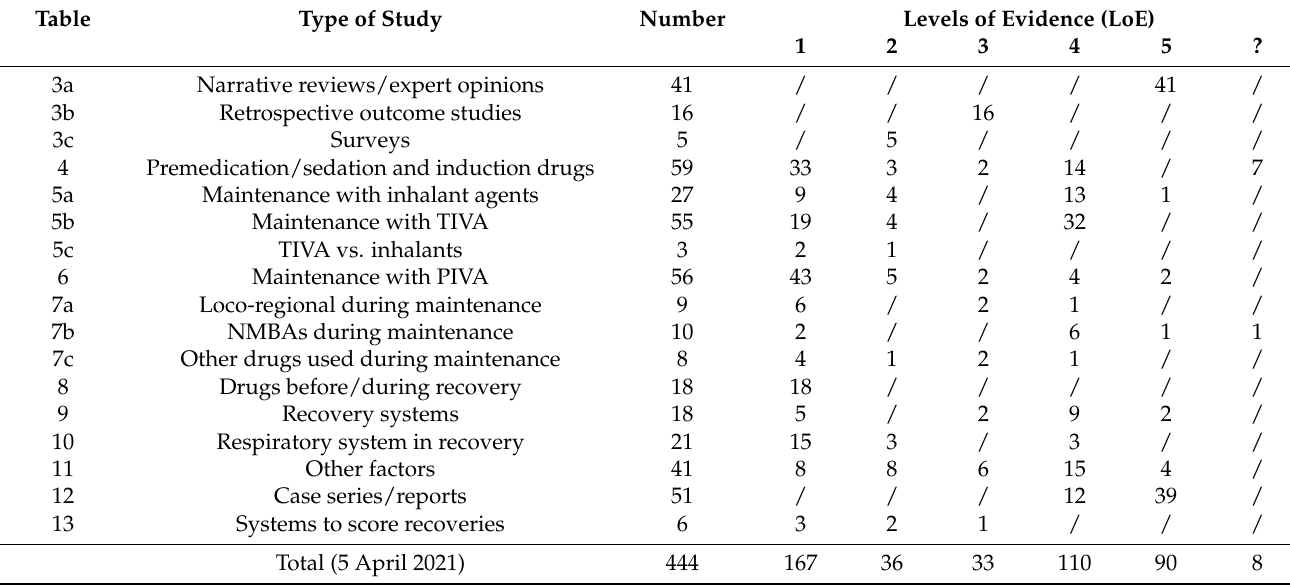
Figure 1. Final list with 444 accepted articles on 5 April 2021. A total of 458 candidate articles were selected. From those, 14 were excluded as they did not fulfil the inclusion criteria or because the abstract was truncated and, therefore, not assessable. Table 2. Final list of 444 selected articles on 5 April 2021, from an updated list of candidate articles of 468 and 727 found with Pubmed and Web of Science,